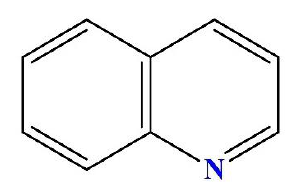
Figure 1. The chemical structure of quinoline.